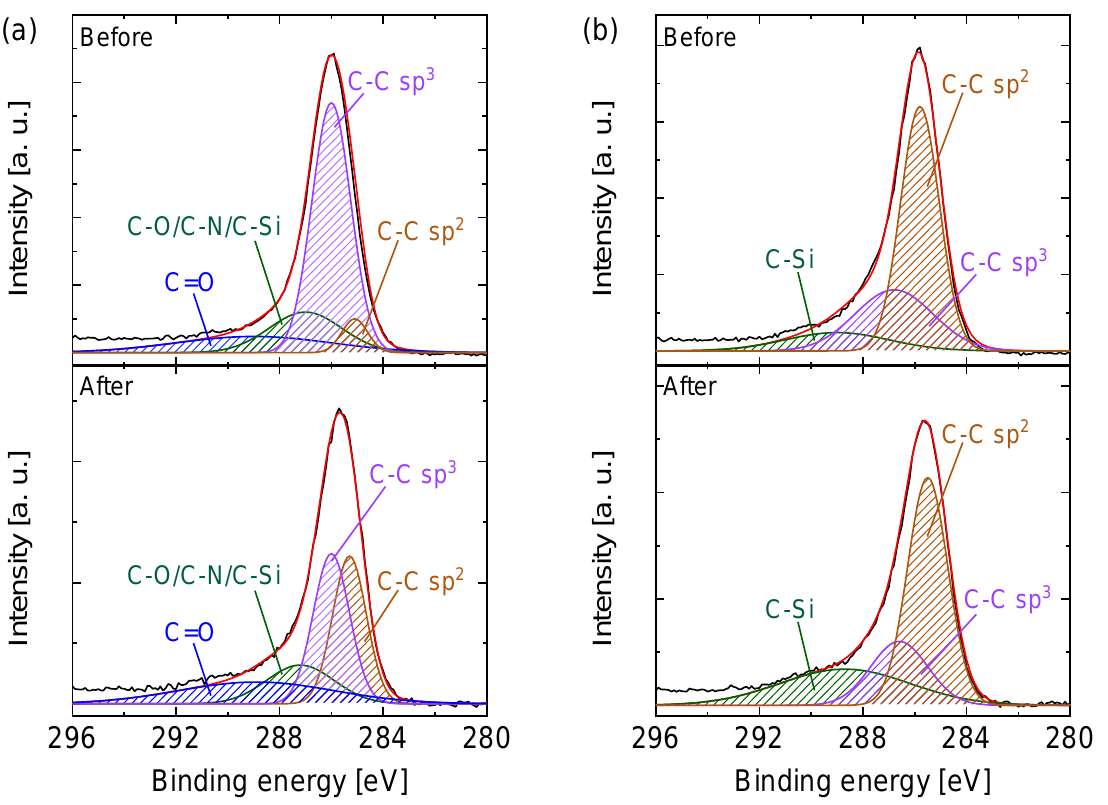
Figure 12. C 1s X-ray photoelectron spectroscopy of carbon-SiO 2 -ZrO 2 films prepared at ( a ) 550 and ( b ) 750 °C before and after 3 h of steam treatment at 500 °C, 90 kPa steam partial pressure.